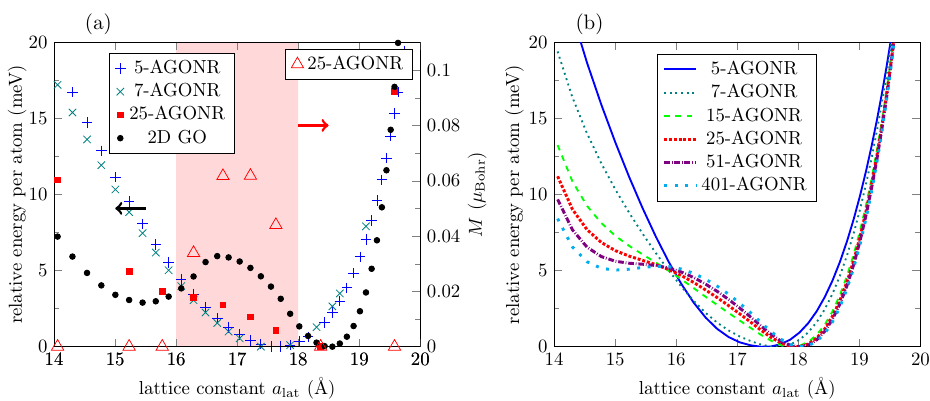
Figure 6. ( a ) Energy evolution of relaxed m -AGONRs with m = 5,7,25 armchair lines, according to DFT calculations. For comparison, ground state energies of the GO layer are included (black circle marks). The red shadowed area indicates non-zero magnetization for a nanoribbon with m = 25 in the corresponding lattice constant range. ( b ) Energy evolution for GO nanoribbons with different widths according to the ML